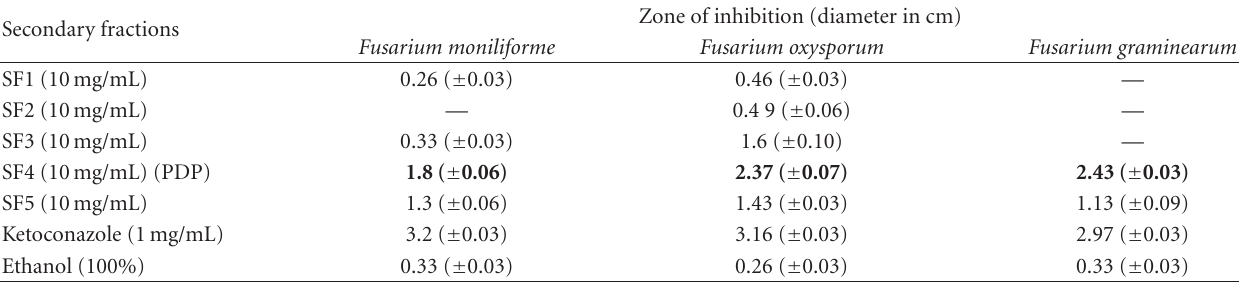
Table 2: Antifungal activity of secondary fraction of petroleum ether extract against plant pathogens. Secondary